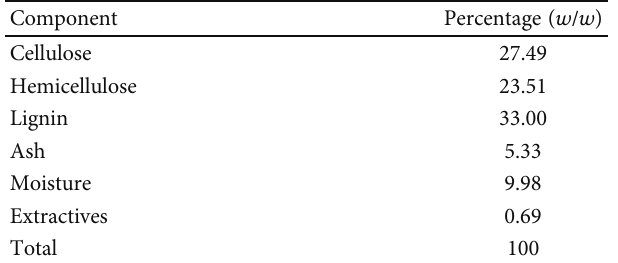
Table 4: Gadam sorghum stalks: results of experimental and predicted glucose